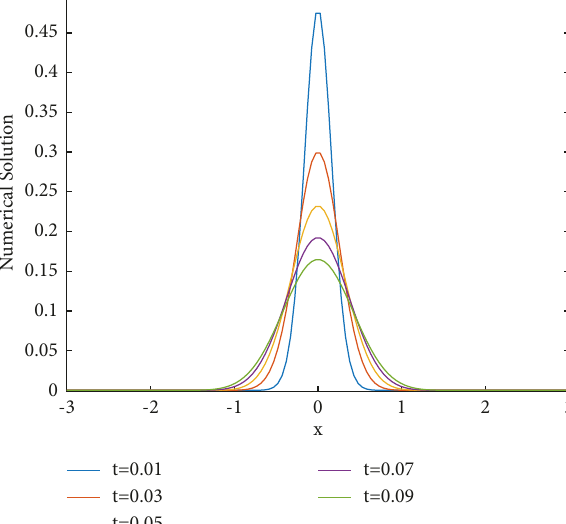
50 (a) and N (cid:31)